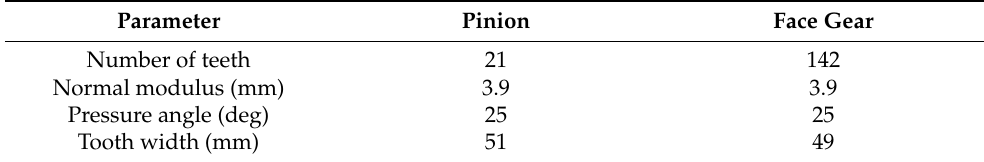
Table 1. Main design parameters of face gear pair.